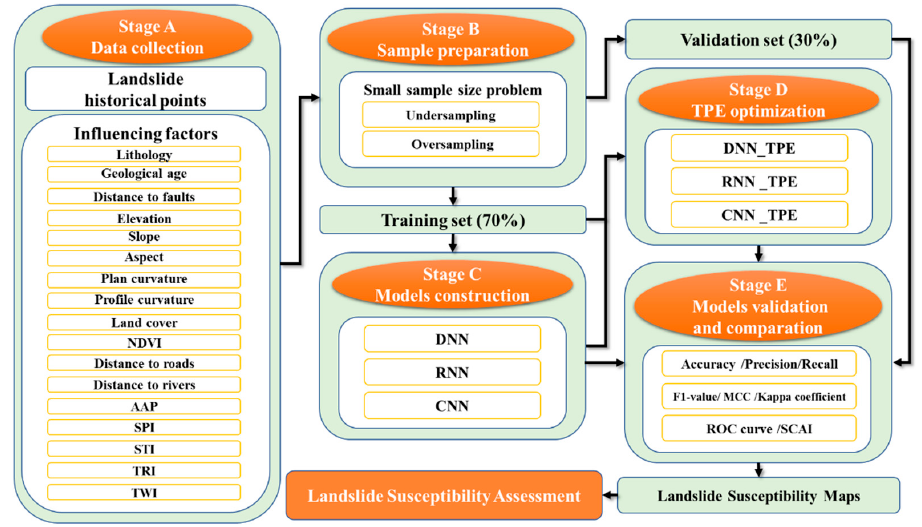
Figure 4. Flowchart of the proposed landslide susceptibility assessment framework.